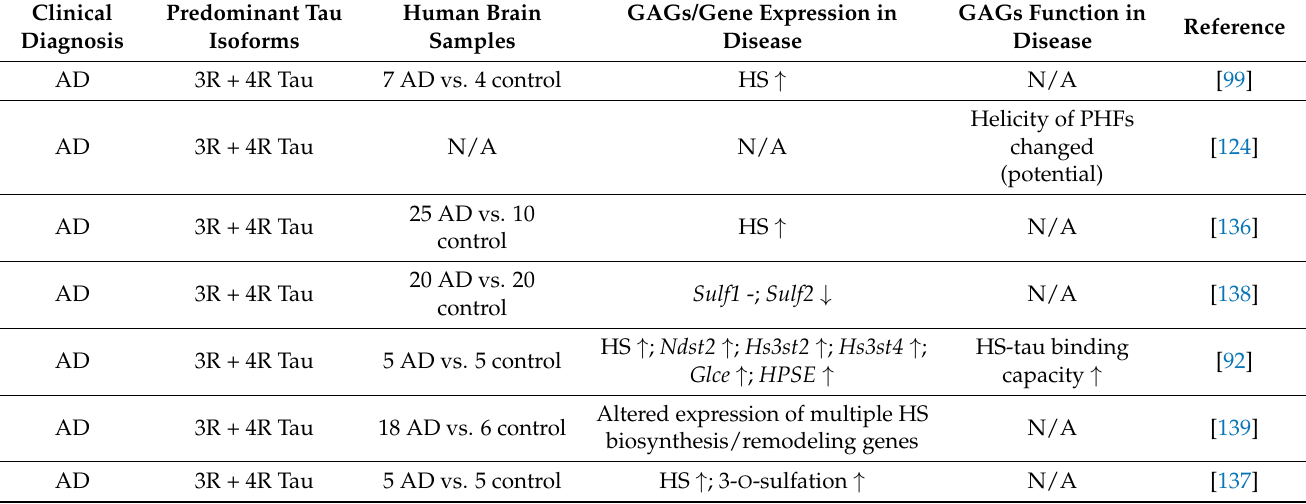
Table 1. Altered HS expression and function in AD patients. -, No change; ↑ , increase; N/A, not